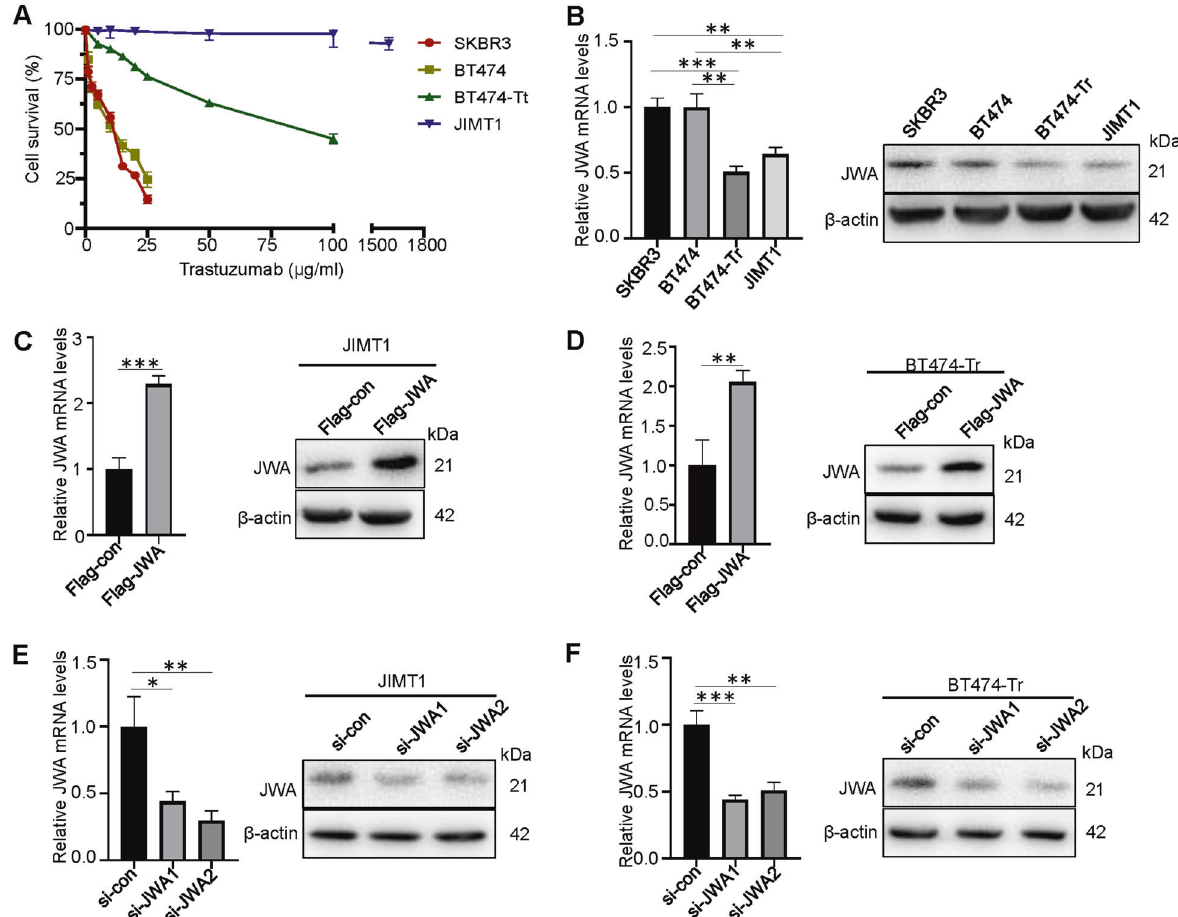
Fig. 2 JWA is low expressed in trastuzumab-resistant breast cancer cells. A Sensitivity to trastuzumab was measured in different HER2 + breast cancer cells by CCK-8. B JWA was measured in different HER2 + breast cancer cells by qRT-PCR and Western blot. C , D JWA was measured by qRT-PCR and Western blot in JIMT1 and BT474-Tr cells stably expressing JWA. E , F JWA was measured by qRT-PCR and Western blot in JIMT1 and BT474-Tr cells transfected with two independent JWA siRNAs. * P < 0.05, ** P < 0.01, *** P <